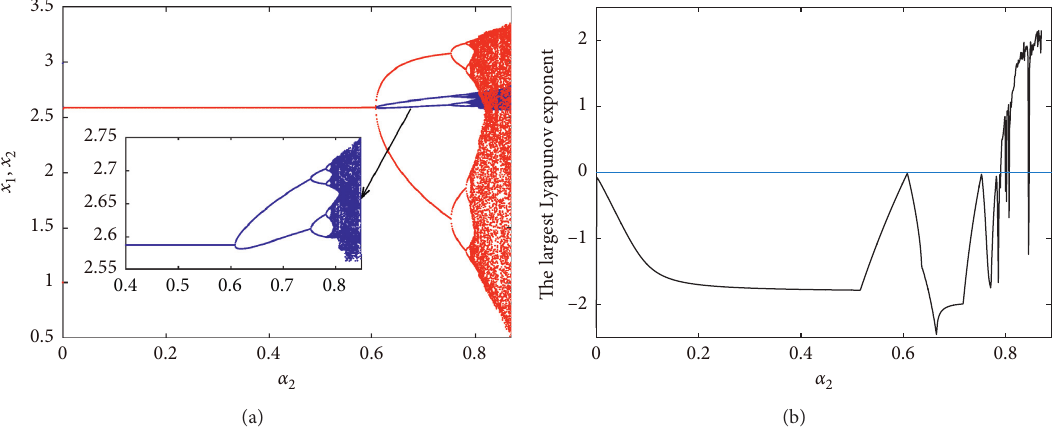
Figure 2: (a) The one-dimensional bifurcation with respect to α Figure